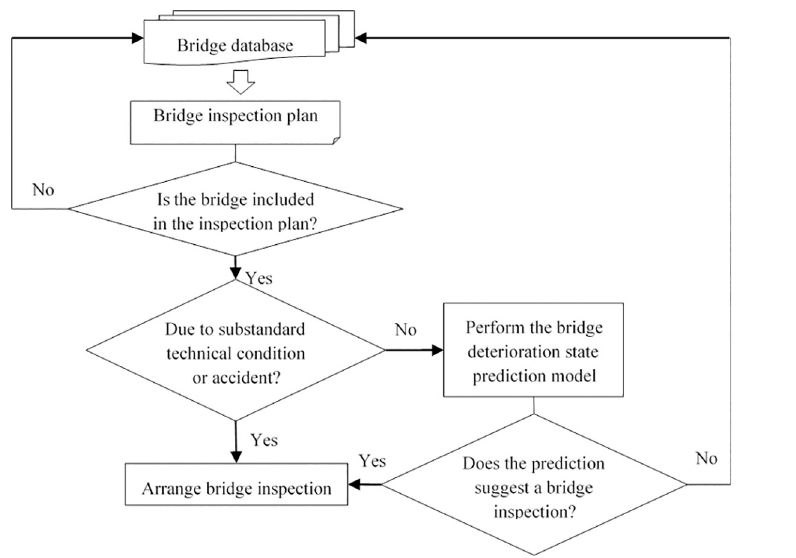
Fig 4. Improved highway bridge inspection scheduling process.